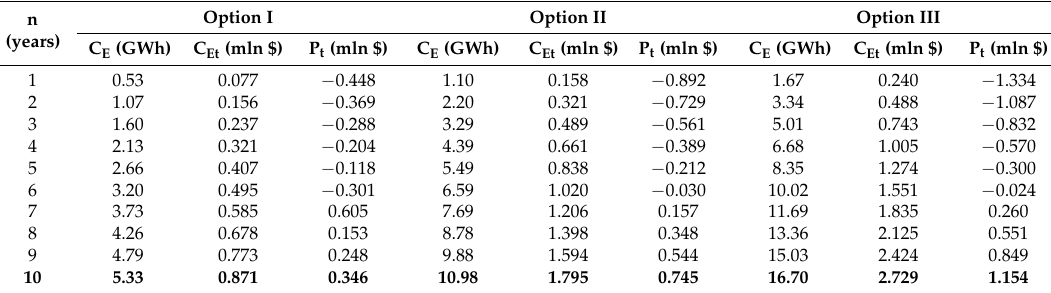
Table 9. ESD total cost and profit for a 10-year period with the new energy